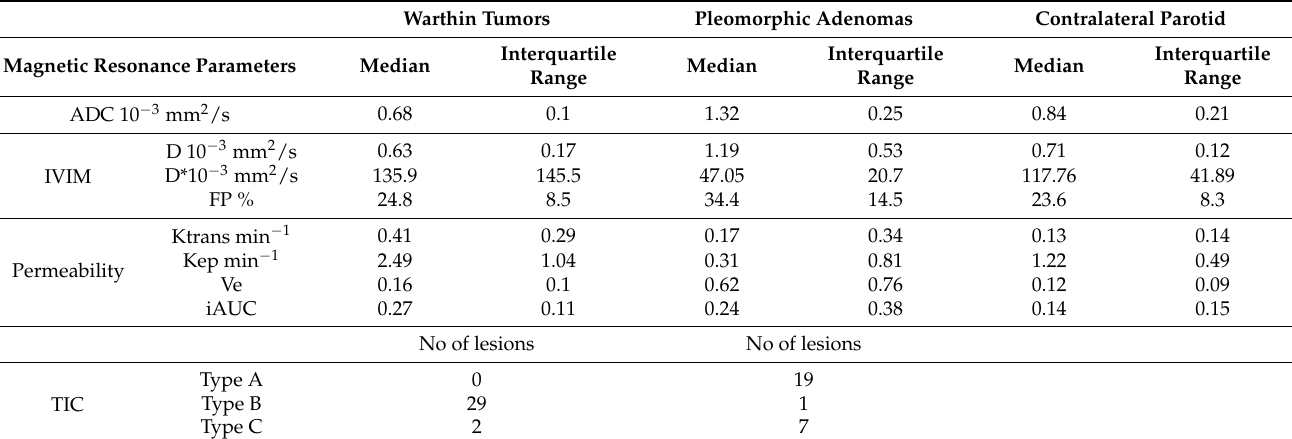
Table 4. Magnetic resonance features of common benign parotid gland